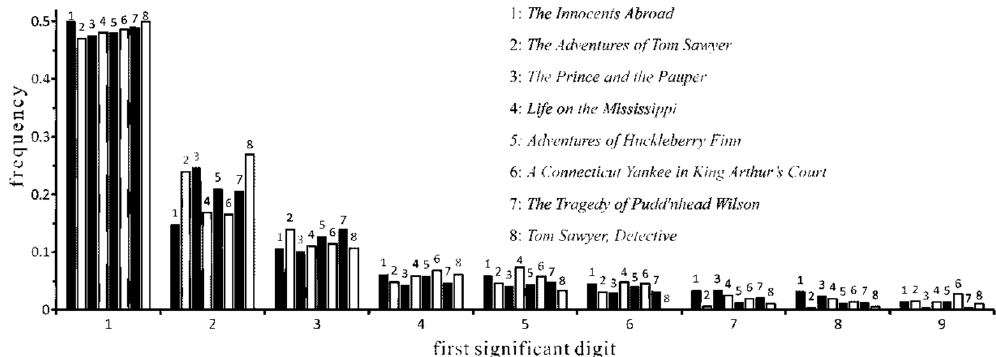
Figure 6. The distribution of the first significant digits of numerals in M. Twain’s texts.